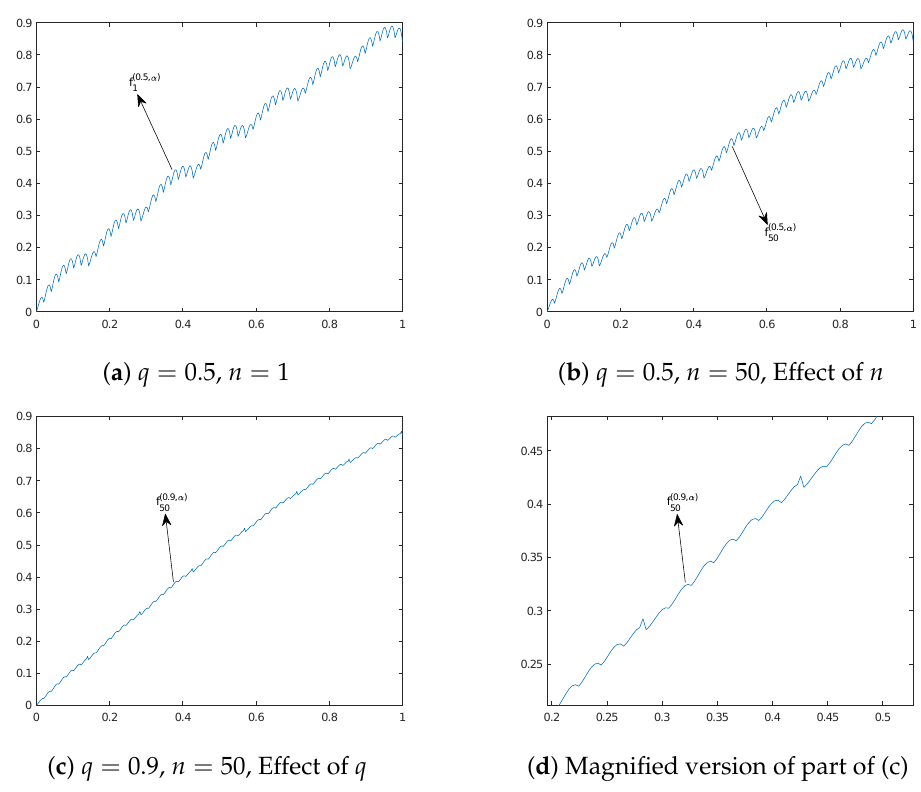
Figure 1. MKZ fractal functions of sin x